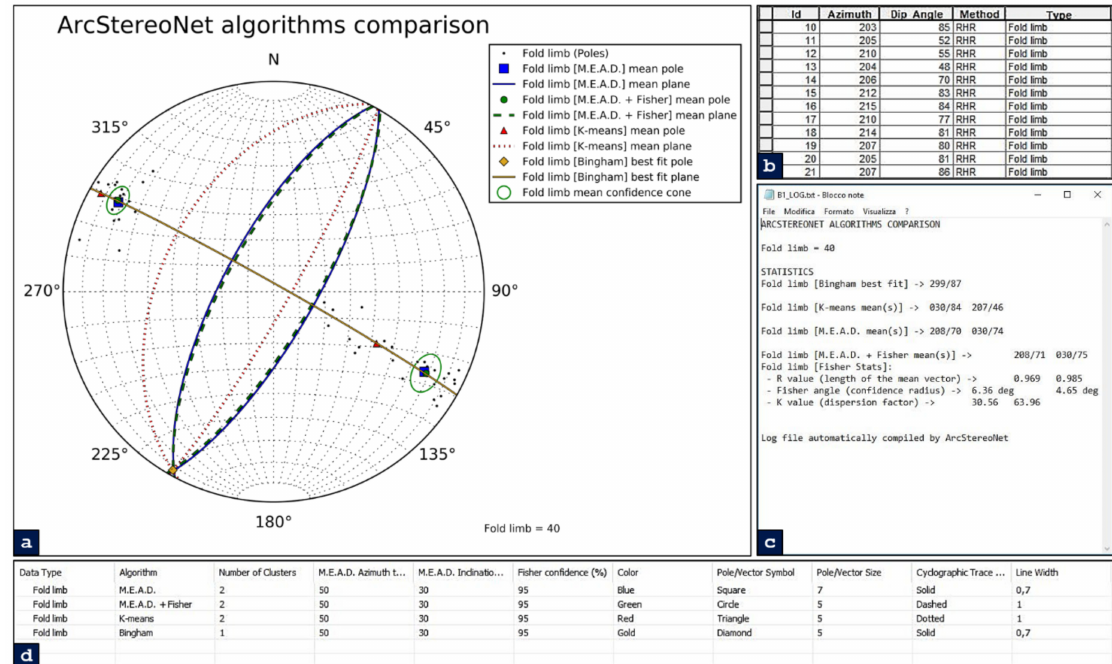
Figure 9. Application of ArcStereoNet algorithms with default control parameters for the extraction of mean vectors from the Macduff area dataset, treated as a single feature type. ( a ) ASN graphic result; ( b ) portion of Macduff dataset attribute table, with all records sharing the same feature type (i.e., “Fold limb”); ( c ) ASN log file showing algorithm statistics and results; and ( d ) “Extract Mean Vector” Value Table showing the algorithm settings.